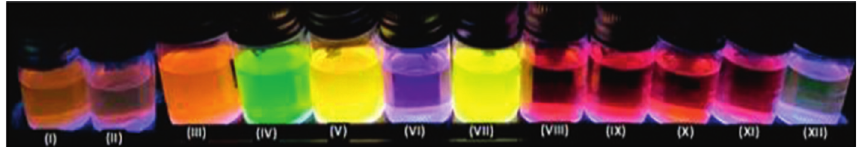
Figure 11: Color display of coumarin 3 emission under a 365nm UV-torch in solvents of different polarities: (I) THF, (II) CCl CH 2 Cl 2 , (IV) C 4 H 9 Cl, (V) CHCl 3 , (VI) EG, (VII) 1,4-dioxane, (VIII) CH 3 CN, (IX) DMF, (X) acetone, (XI) CH 3 OH, and (XII) C 2 H 5 OH.